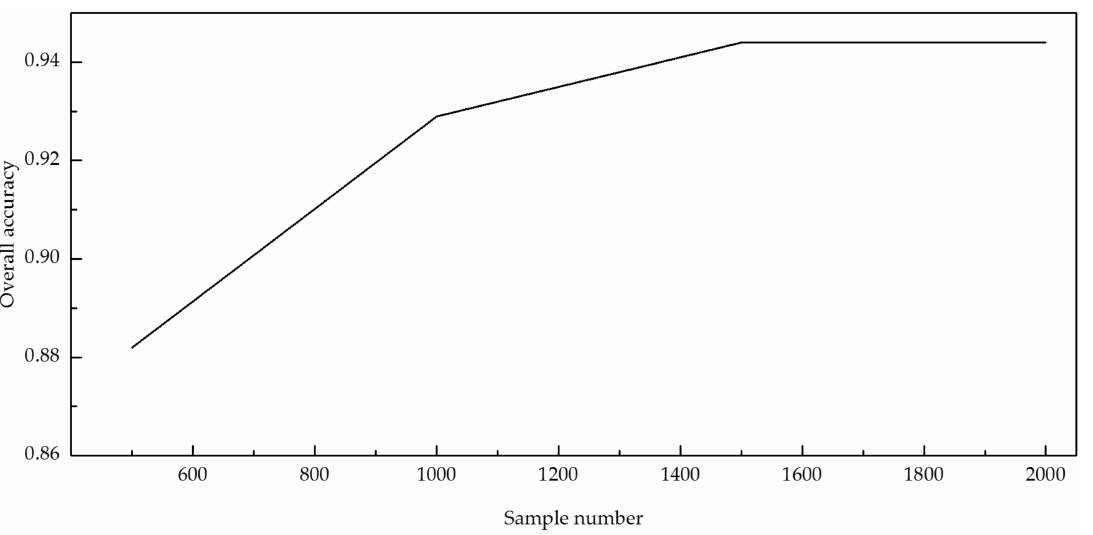
Figure 9. Classification accuracy with decreasing training set size.